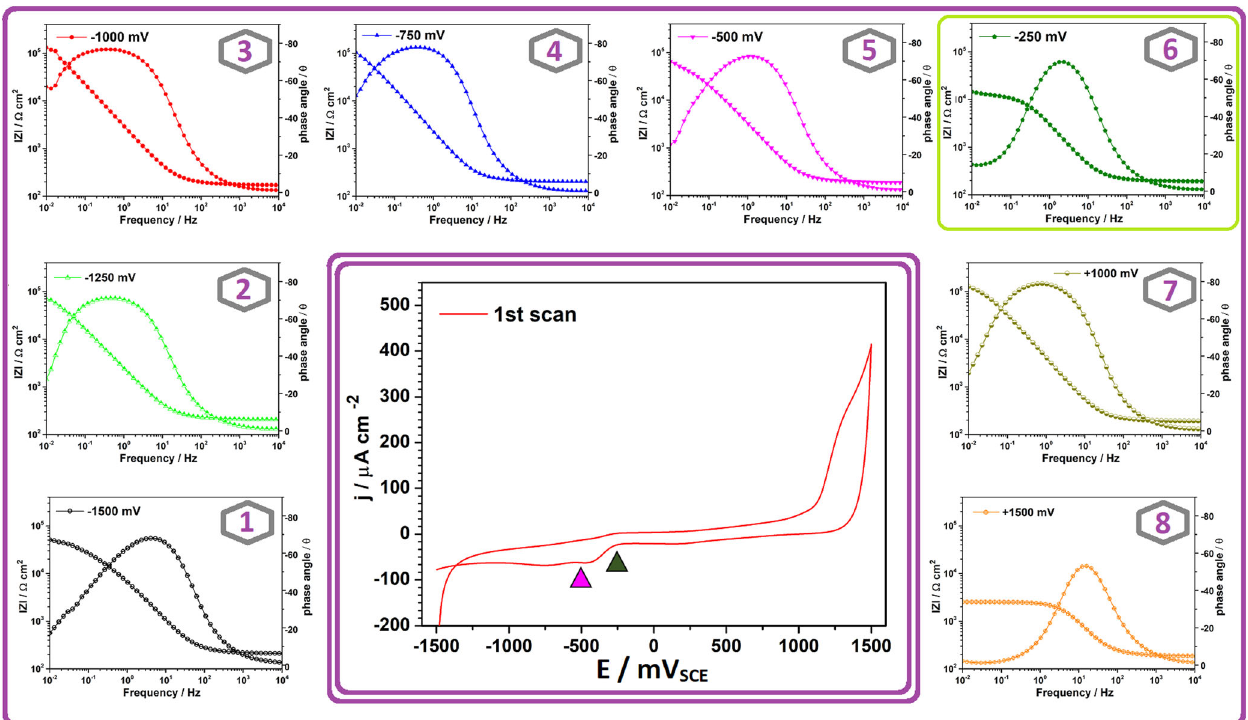
Fig. 7 Cyclic voltammogram of CFRP with EIS data at different polarizations. Cyclic voltammogram of CFRP during 10 cycles (1st scan) in 50 mM NaCl at a scan speed of 10 mV s − 1 (Insets 1 – 8 are EIS spectra in Bode plot format at cathodic and anodic potentials of interest).